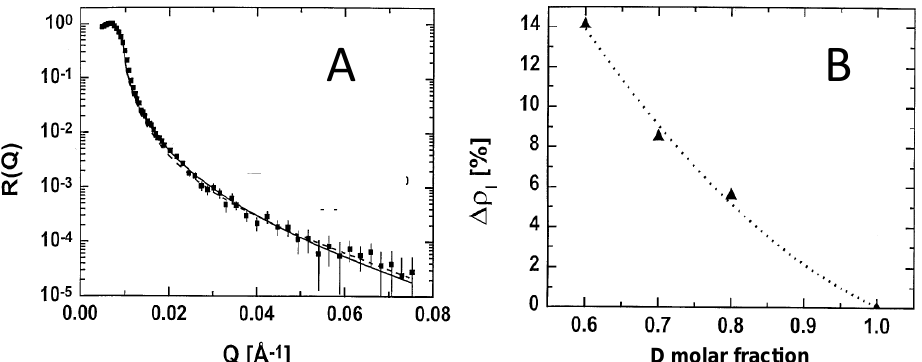
Figure 5. Experimental neutron reflectivity ( R ( Q ) ; log-scale) from Si/water interface. ( A ) measured and fitted reflectivity data for the Si/liquid interface of H 2 O-D 2 O mixture with D molar fraction x D = 0.6 at room temperature; ( B ) the observed “anomalous” increase of the scattering length density of the liquid at the solid–liquid interface for the additional layer models investigated in [25]: Relative deviation ∆ ρ I of the observed scattering length density ρ I of the (assumed) fictitious layer at the interface (with thickness d I ≈ 50 Å) from the conventionally expected scattering length density ρ th of the bulk liquid, for various H 2 O-D 2 O mixtures. (Reproduced from [25], with permission from